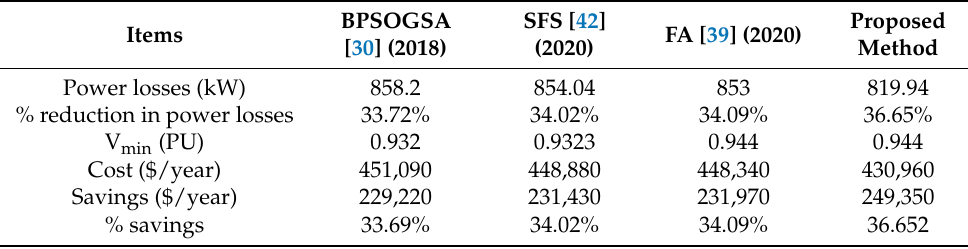
Table 7. IEEE 119 system with reconfiguration only.